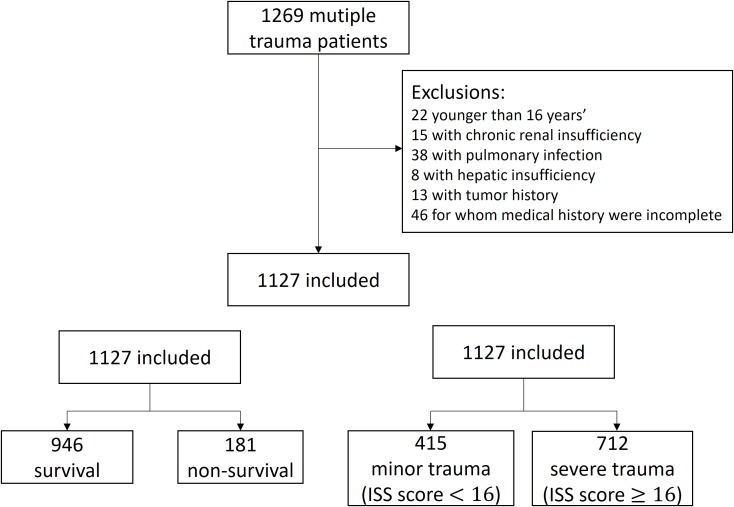
Study population.